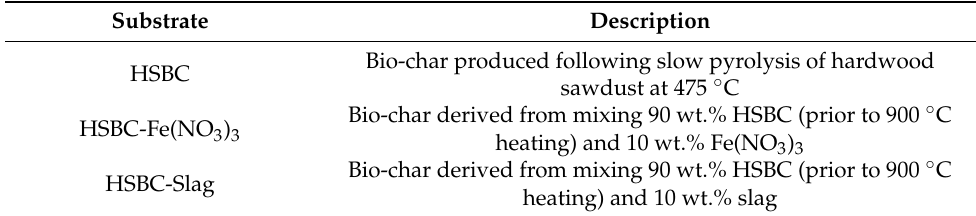
Table 9. Modification of the substrate’s chemical